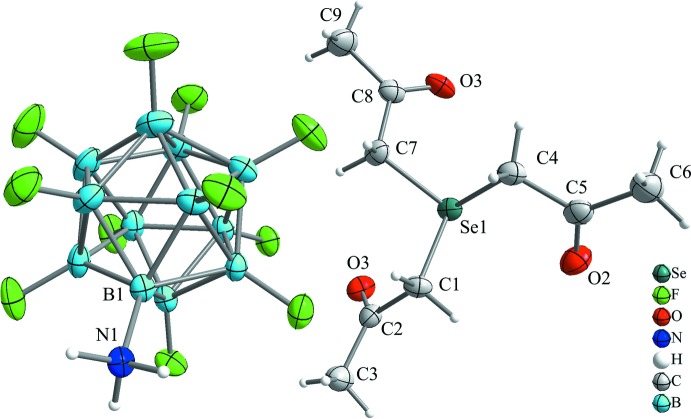
Part of the crystal structure of [Se(CH2C(O)CH3)3][B12F11NH3]. Displacement ellipsoids are drawn at the 50% probability level and hydrogen atoms are shown with arbitrary radii.